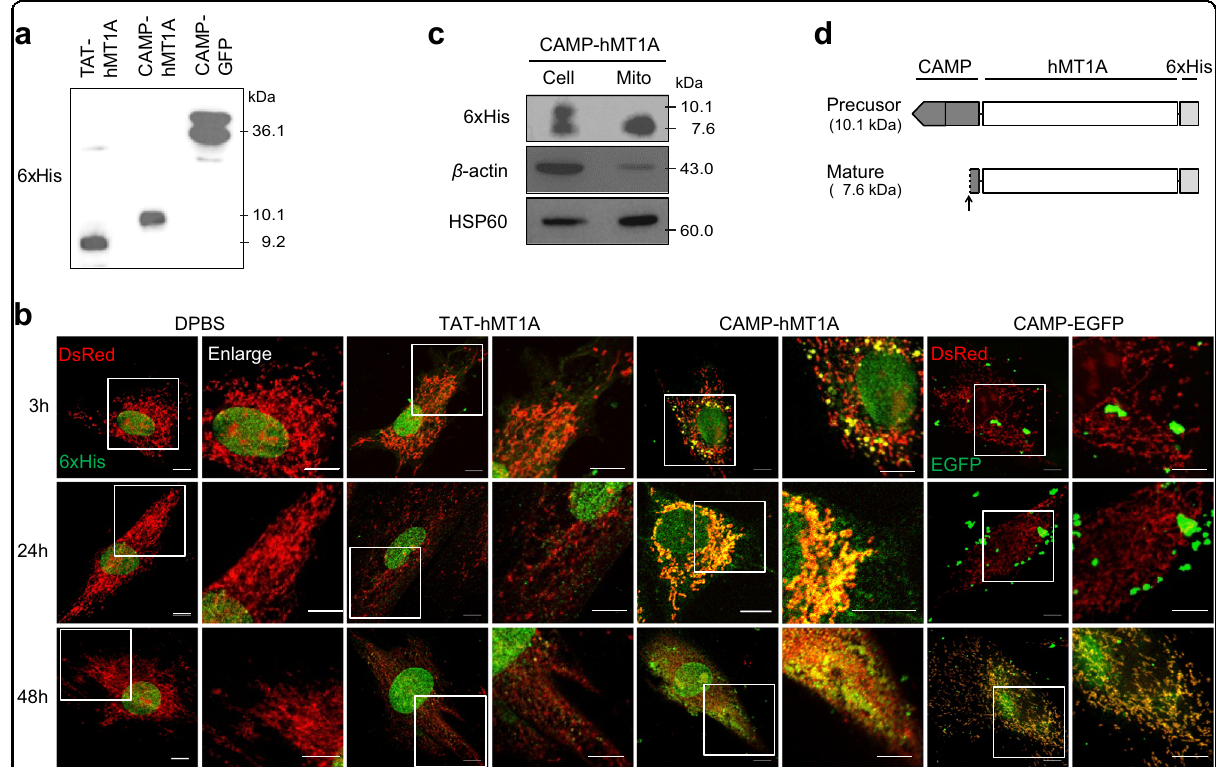
Fig. 4 Transfer of CAMP-hMT1A protein into mitochondria. a Western blot of TAT-hMT1A, CAMP-hMT1A, and CAMP-EGFP recombinant proteins using 6xHis-tag antibody. b Time-dependent uptake of recombinant proteins. SK-Hep1 cells expressing DsRed2-mito (red) were treated with 2 μ M CAMP-hMT1A, TAT-hMT1A, or CAMP-EGFP for 3, 24, or 48 h. Cells were immunostained with 6xHis-tag or EGFP antibodies (green) before confocal microscopy (×400, scale bar = 10 μ m). The yellow merged images show mitochondrial localization of the fusion proteins. c Western blot of CAMP- hMT1A in mitochondria isolated from cells treated with 2 μ M CAMP-hMT1A for 24 h. The upper and lower bands of CAMP-hMT1A represent the precursor and mature forms, respectively. β -Actin and HSP60 antibodies were used for loading and mitochondria control, respectively. d Schematic representation of the precursor and mature forms of CAMP-hMT1A. The processing site is indicated by an